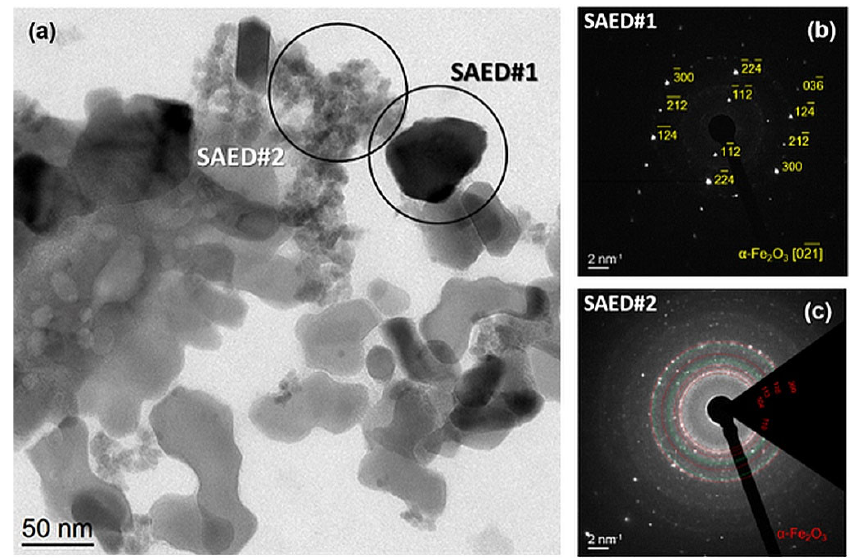
Figure 3. Bright-field TEM image of sample Fe 2 O 3 _Na-500: ( a ) SAED pattern of a large hydrohematite particle ( b ) and SAED pattern of the agglomerate of small particle containing a mixture of hydrohematite and ferrihydrite ( c ).